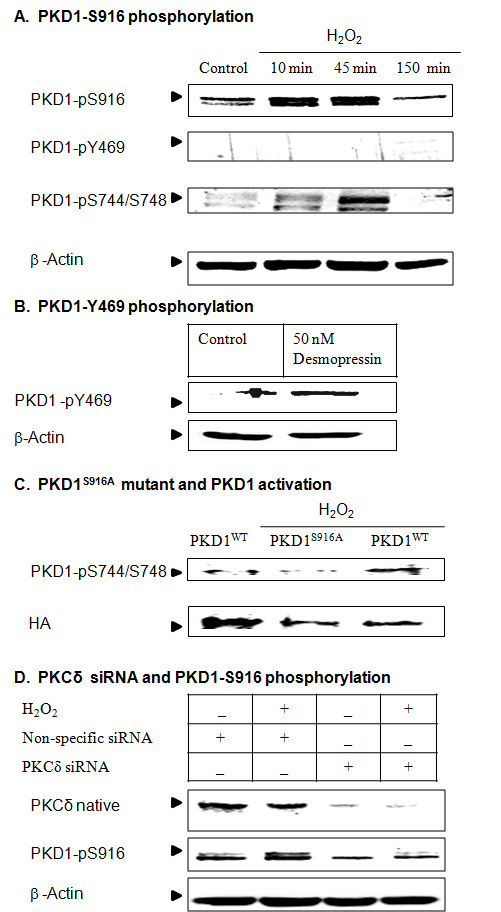
PKCδ-dependent phosphorylation of PKD1 at S916 site precedes PKD1 S744/S748 active loop phosphorylation. N27 dopaminergic cells were treated with 100 μM H2O2 for 10-90 min and monitored for PKD1Y469, PKD1 S916 and PKD1 S744/S748 phosphorylation (A). N27 dopaminergic cells were treated with or without 50 nM desmopressin for 1 h and monitored for PKD1 Y469 phosphorylation. The cells show PKD1 Y469 phosphorylation when exposed to desmopressin, while carbachol does not cause PKD1 Y469 phosphorylation (B). N27 cells expressing PKD1S916A mutant blocked PKD1 activation during oxidative stress, as seen by Western blotting for PKD1 S744/S748 phosphorylation and HA expression (C). N27 dopaminergic cells were transfected with 1 μM PKCδ siRNA and non-specific siRNA and monitored for PKCδ protein expression and PKD1 S916 phosphorylation after treatment with or without H2O2 (D).